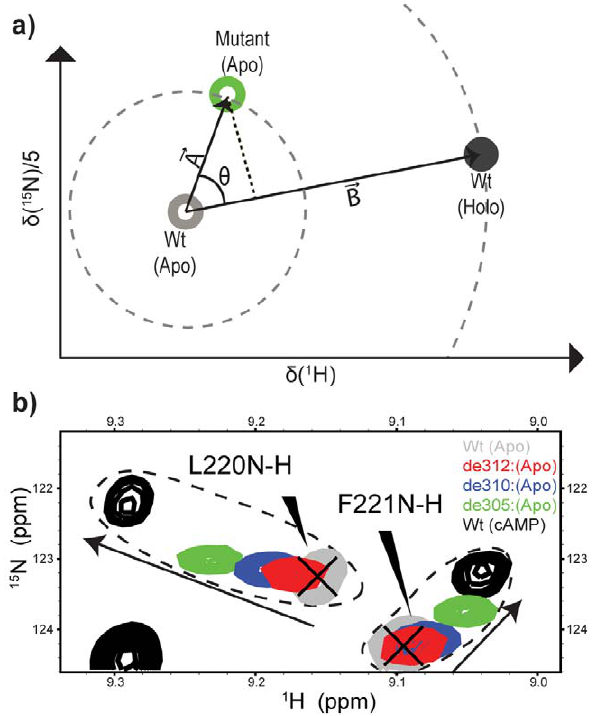
Figure 2. Chemical shift projection analysis (CHESPA) using mutations as perturbations. a ) Schematic of CHESPA. Open circles indicate HSQC peaks of the apo forms, whereas the filled circle represents the holo form (cAMP bound) HSQC peak. The green open circle represents the apo-mutant. The compounded chemical shift between the Wt(apo) and Wt(holo) was computed as the magnitude of the vector B, |B|. Similarly the compounded chemical shift between the Wt(apo) and Mutant(apo) was calculated as |A|. The magnitude of vectors A and B define the radii of the dashed circles centered on the Wt(apo) peak ( b ) Representative regions of the [ 15 N- 1 H] HSQC spectra of Wt(apo) (grey) and cAMP-bound, Wt(holo) (black) overlaid with the [ 15 N- 1 H] HSQC spectra of apo-Mutants: de312 (red), de310 (blue), de305 (green). Arrows indicate the direction of shift toward activation and dashed contour lines enclose peaks of the same